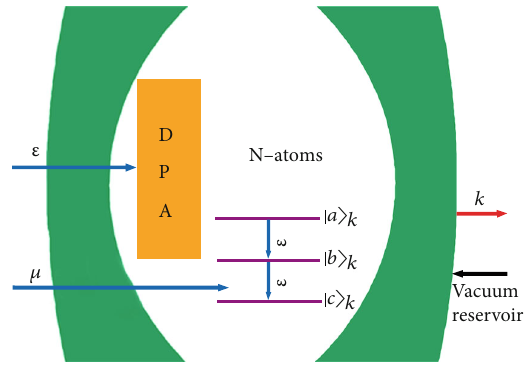
Figure 1: Schematic representation of a degenerate three-level laser with a degenerate parametric ampli fi er (DPA) and coupled to a two- mode vacuum reservoir. Here, ε , considered to be real and constant, is proportional to the amplitude of the pump mode that drives the nonlinear crystal (NLC), and μ is the amplitude of the driving coherent light that couples the top and bottom levels of the atom. And also κ is the cavity damping constant, and it is assumed the same for both transitions. The top, middle, and bottom levels of the three-level atom are denoted by j a i , j b i , and j c i , k k k respectively, where as k = 1, 2, ⋯ N are the number of atoms inside → the cavity. When the atom makes a transition from level j a i k h b j → h c j and from levels j b i two photons with the same k k k frequencies, ω , are